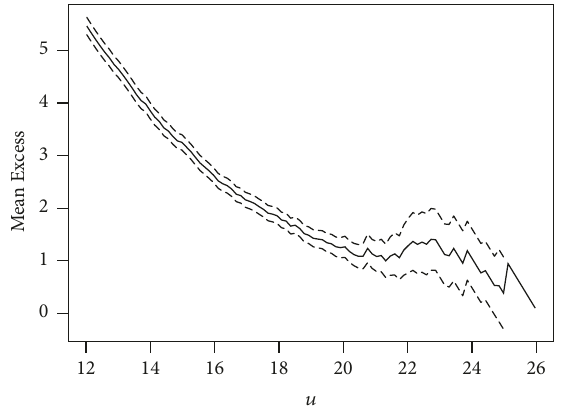
Figure 2: Mean excess plot of losses.